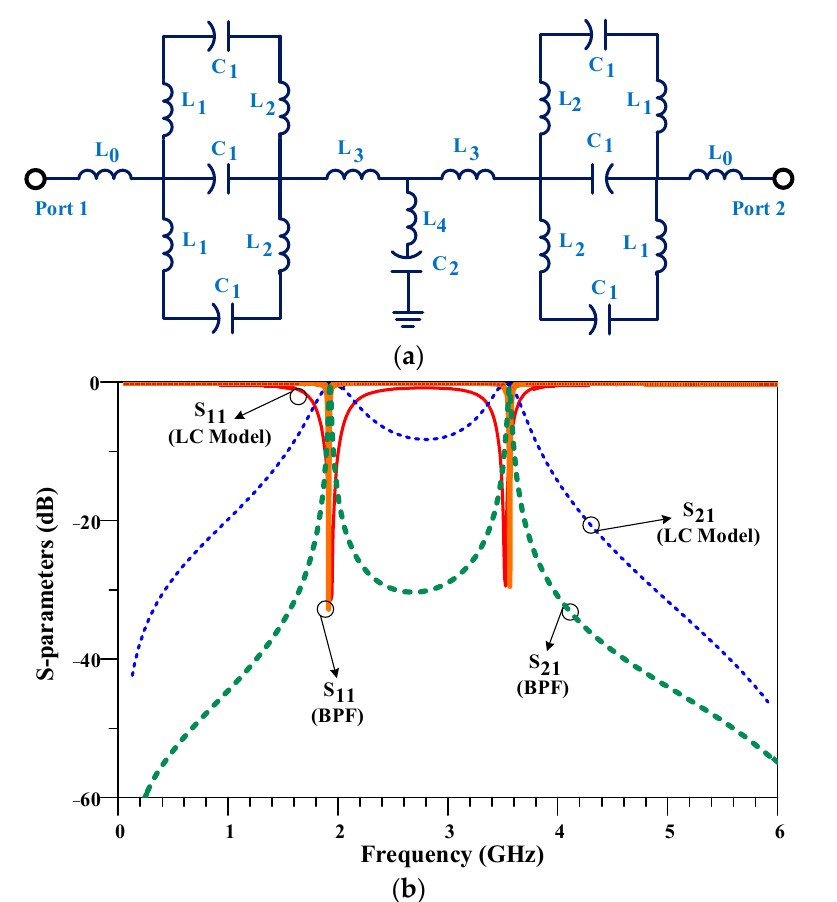
Figure 6. The ( a ) schematic of simplified LC equivalent circuit model and ( b ) its frequency response for the first proposed BPF at 1.9/3.6 GHz. The circuit parameters of the proposed LC model are as follows: L 0 = 5 nH, L 1 = 8.2 nH, L 2 = 8.5 nH, L 3 = 13.3 nH, L 4 = 2.1 nH, C 1 = 0.1 pF, and C 2 = 0.19 pF.